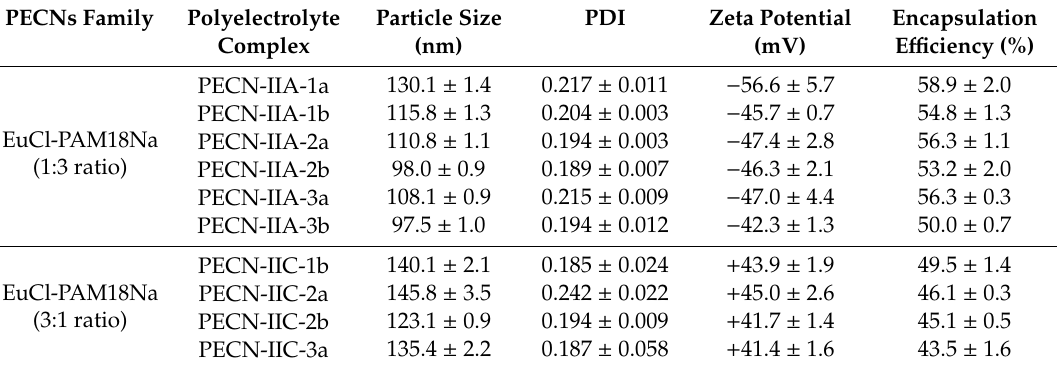
Table 3. Data of polyelectrolyte complexes that comply with the physicochemical quality criteria defined in the study (i.e., particle size < 200 nm, PDI < 0.3, zeta potential ~ | 40 | mV, and encapsulation e ffi ciencies of ampicillin >